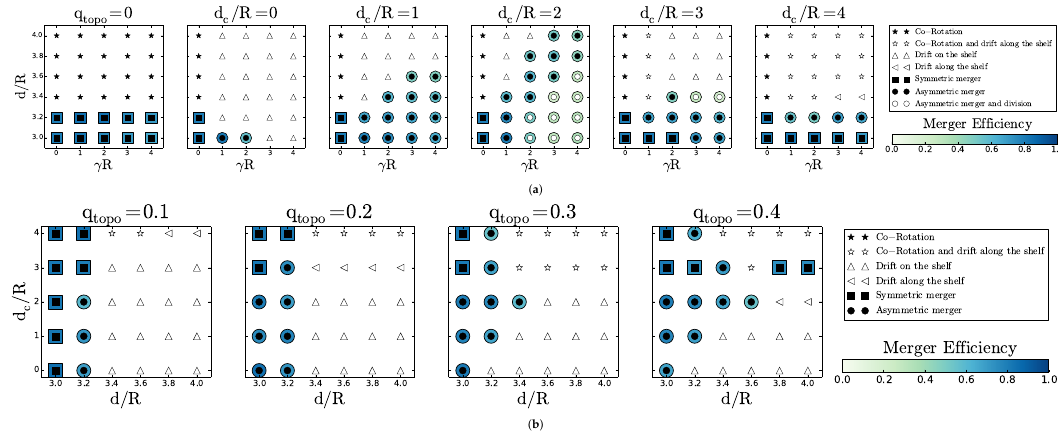
Figure 3. Regime diagram for the interaction of two surface cyclones with: ( a ) given d c / R (see above each plot) in the γ R , d / R plane for f 0 h b 0 H 2 = 0.3; ( b ) given topographic vorticity (see above each plot) in the d / R , d c / R plane. Black stars indicate co-rotation; white stars represent co-rotation and drift along the shelf/slope; black squares indicate symmetric merger; black circles represent asymmetric merger; white circles denote asymmetric merger and vortex splitting; upward pointing triangles represent drift towards and on the slope and shelf; and triangles pointing left represent drift along the shelf/slope. The blue shading provides the value of the merger efficiency, when